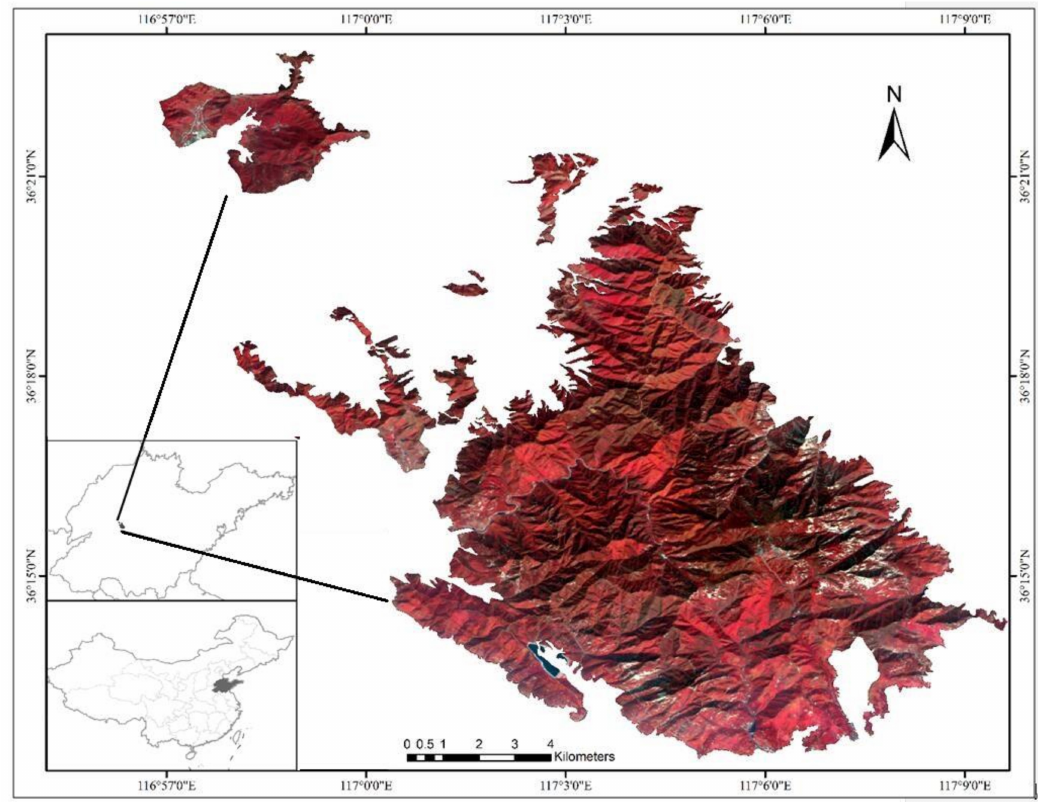
Figure 1. Location of the study